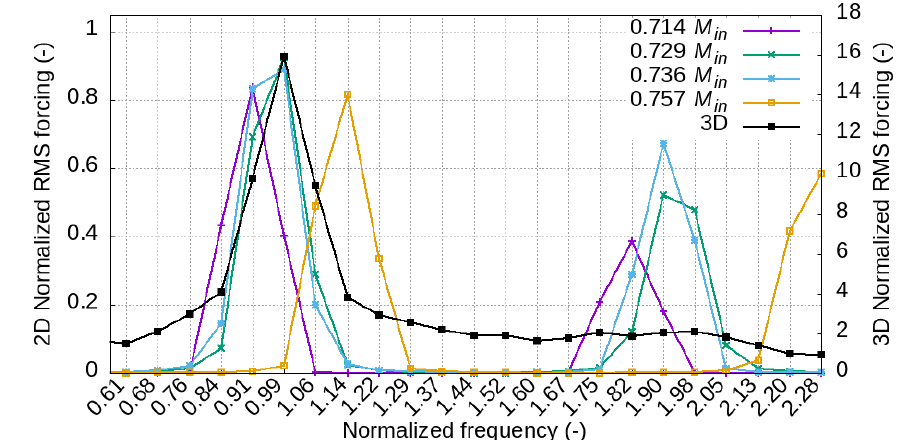
Figure 7. Parametric study forcing frequency spectra and amplitudes, varying M in with constant β .